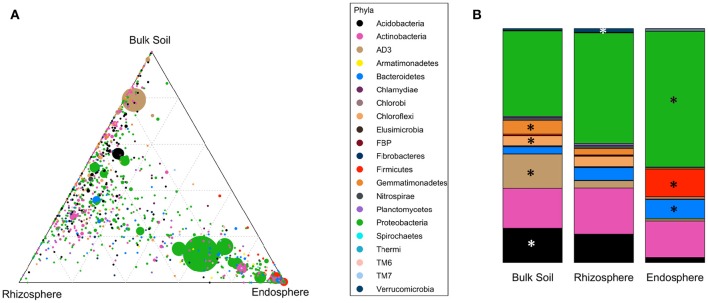
Distribution of OTUs and phyla across different compartments. (A) Ternary plot of all OTUs plotted based on the compartment specificity. Each circle represents one OTU. The size, color and position of each OTU represents it relative abundance, bacterial phyla and affiliation of the OTU with different compartments, respectively. (B) Distribution of average relative abundance of selected major bacterial phyla from all three regions across the compartments. Major phyla (average relative abundance above 1%) with significantly differential distribution (detected by Kruskal-Wallis analysis) are marked with asteriskses.